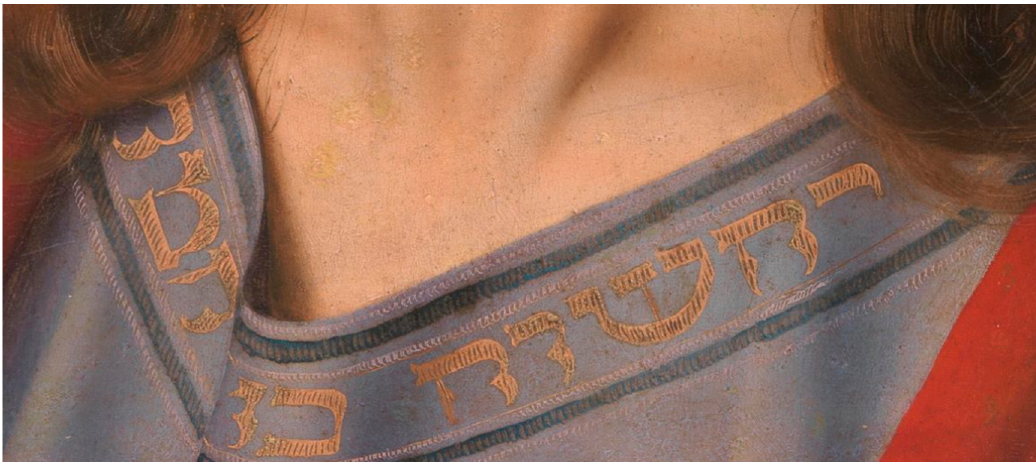
Figure 3. Quentin Massys. Christ the Saviour (detail), ca. 1529. Madrid, the Prado Museum. Courtesy of the Prado